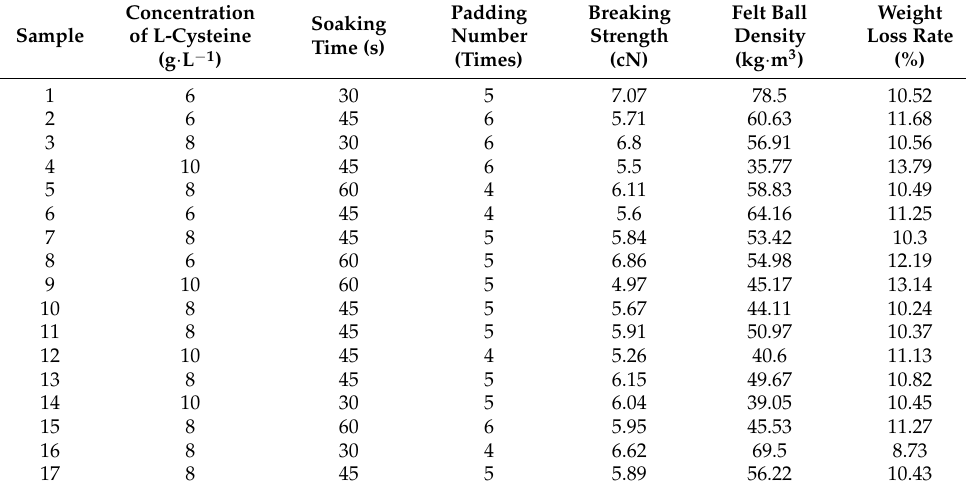
Table 1. Experimental design and responses of the shrink-proof finishing